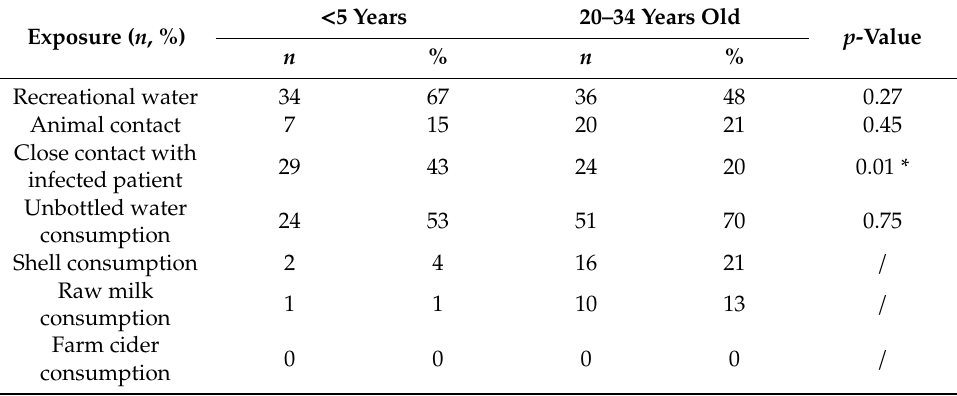
Table A2. Associations between risk factors and most represented age